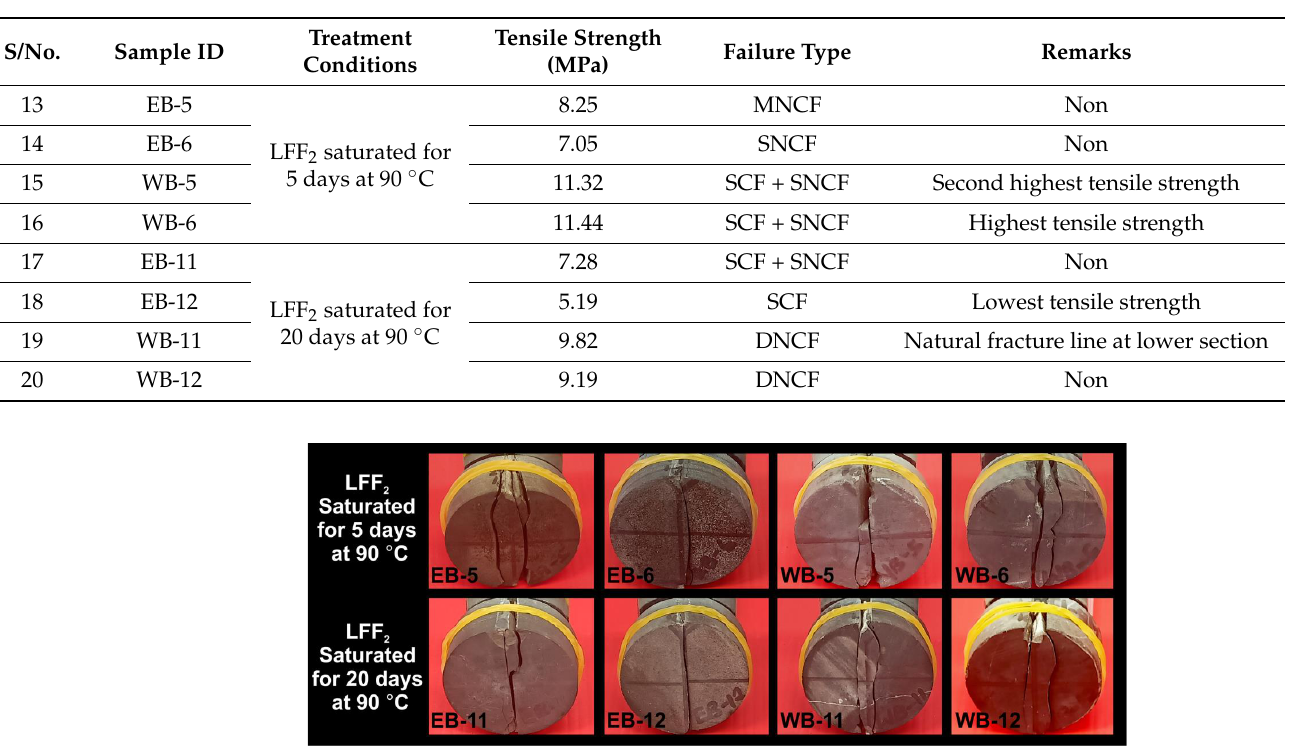
Table 2. Tensile failure analysis of samples subjected to LFF 2 saturation at 90 ◦ C for the periods of 5 and 20 days prior to BITS testing. Identified failure patterns included SCF, SNCF, DNCF, and MNCF. S/No.